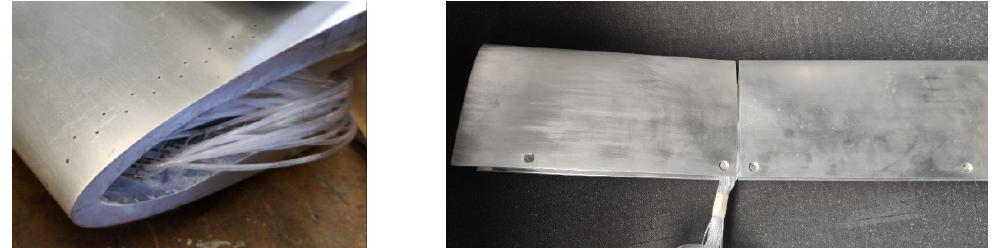
Figure 4. Pressure taps at one leading edge.